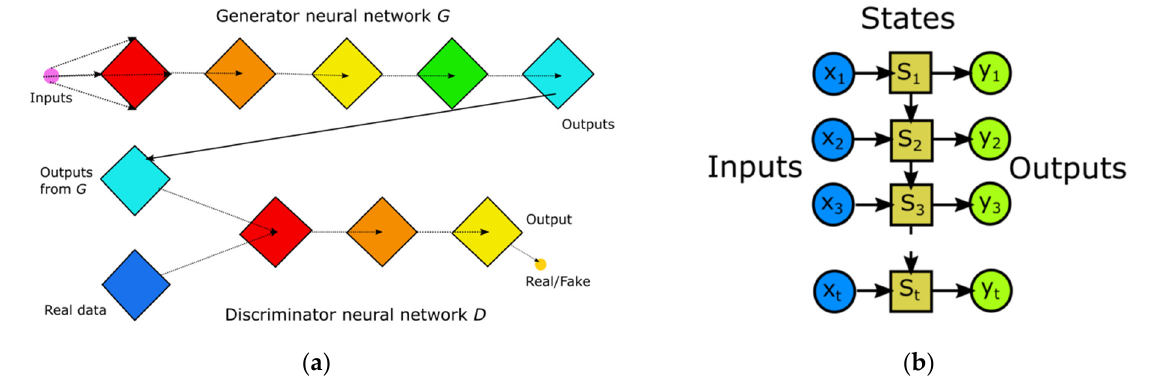
Figure 17. ( a ) Generative adversarial network. ( b ) Recurrent neural network (based on 11]).